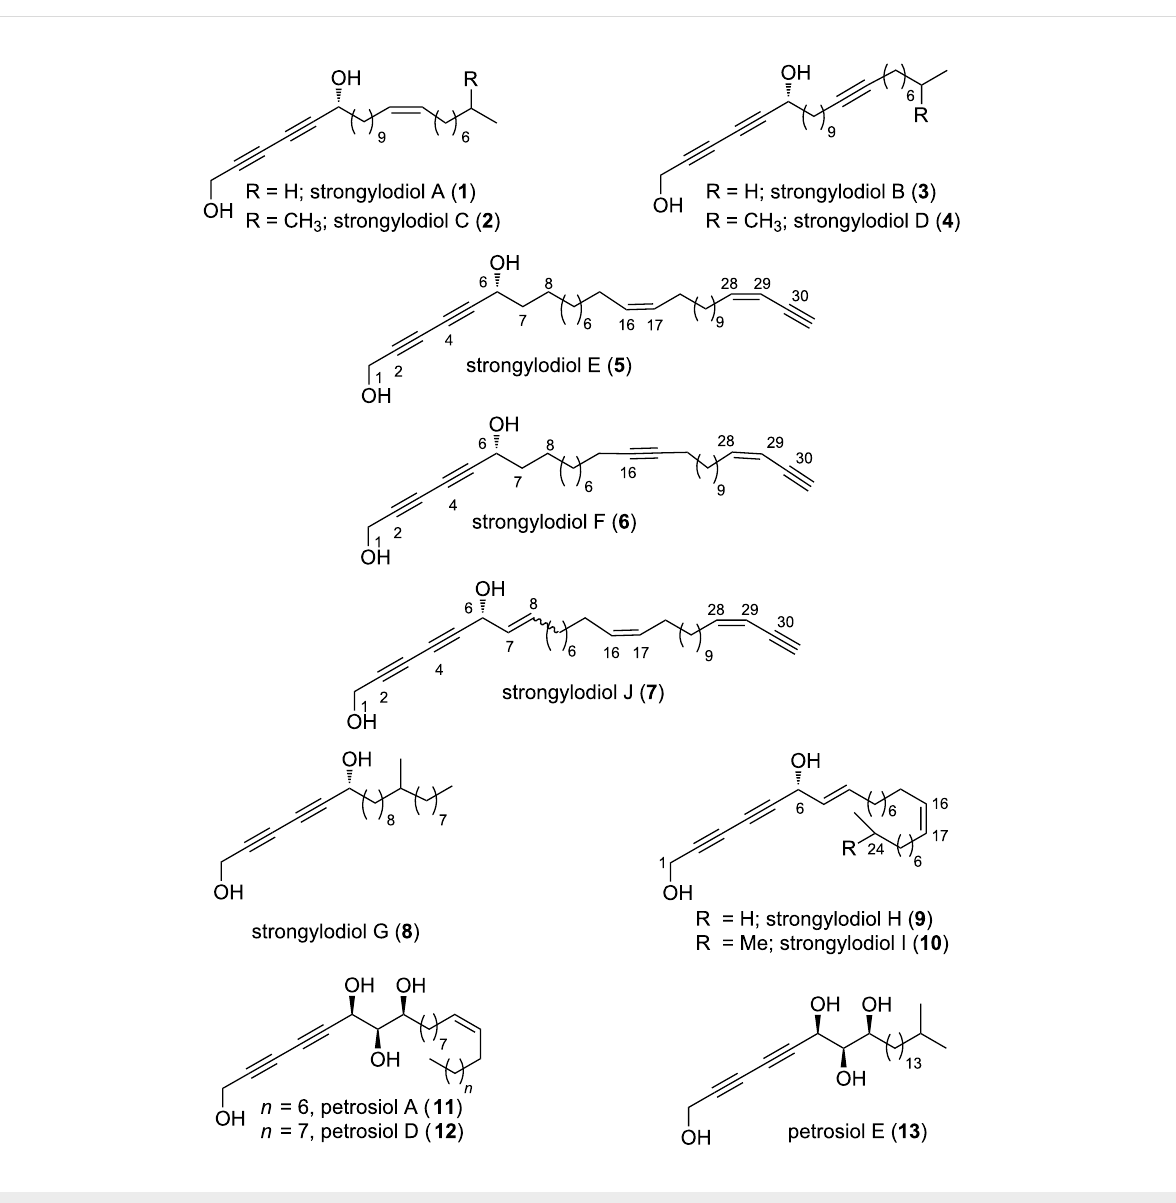
Figure 1: Proposed structures of a selection of diacetylenic polyol natural